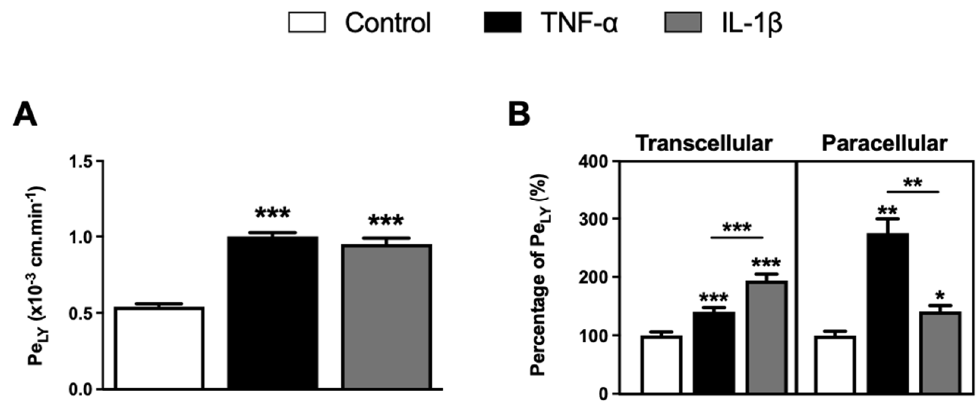
Figure 2. Effects of TNF- α or IL-1 β treatments on BLEC monolayer permeability. ( A ) Following proinflammatory cytokine treatments, BLEC monolayer integrity was determined by measuring the endothelial lucifer yellow permeability (Pe LY ). ( B ) The paracellular permeability of LY through BLEC monolayer was also determined by measuring the Pe LY at 4 °C, which corresponds to a condition − inhibiting transcellular pathway. The transcellular permeability of LY through BLEC monolayer was deducted by subtracting the total permeability of LY from its paracellular permeability. The percentage of Pe LY values was established in relation to their control condition. The control values for total, paracellular and transcellular Pe LY are equal to 0.54 ± 0.02 × 10 − 3 , 0.18 ± 0.01 × 10 − 3 and 0.36 ± 0.02 × 10 − 3 cm.min − 1 , respectively. Each bar represents the mean ± SEM and is representative of at least three independent experiments performed in triplicate. The threshold for statistical significance compared to the control condition or among proinflammatory cytokines was set to * p < 0.05; ** p < 0.01; *** p < 0.001.